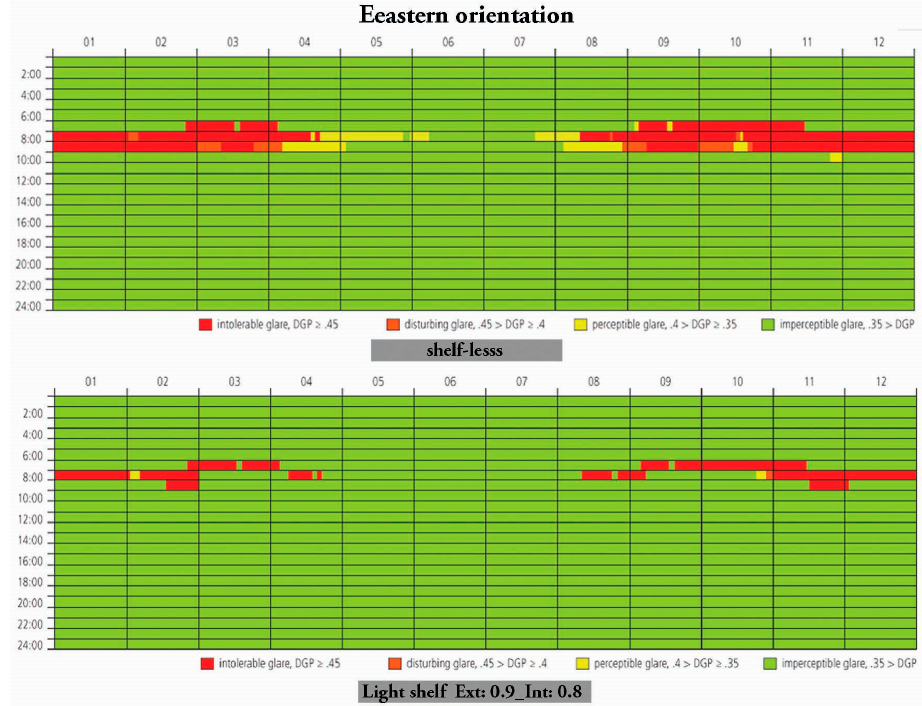
Figure 7. The results of the annual daylight glare probability sample for the eastern orientation, to consider more accurately the few data for the east and west orientation, shown as a percentage in Figure